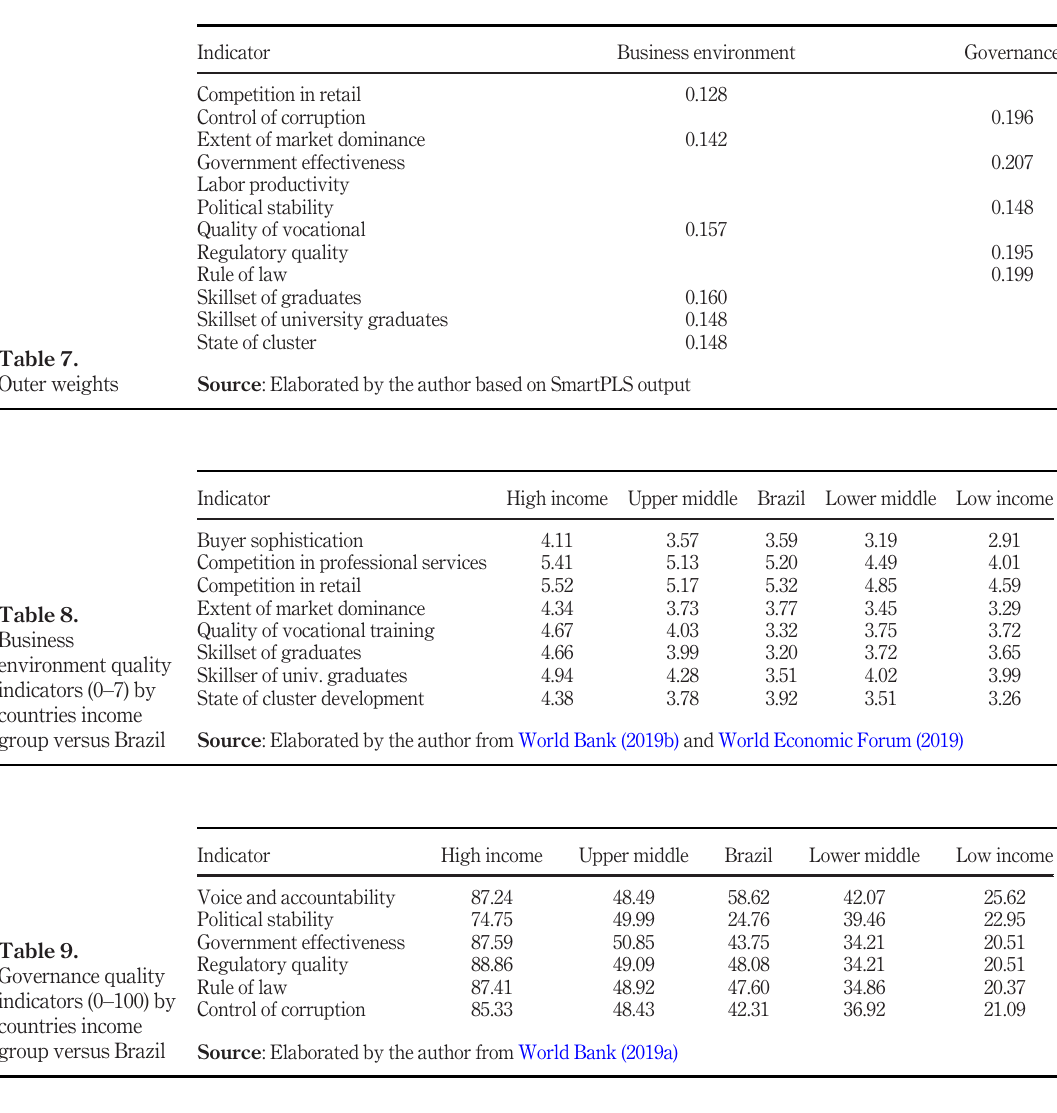
Indicator Business environment Competition in retail